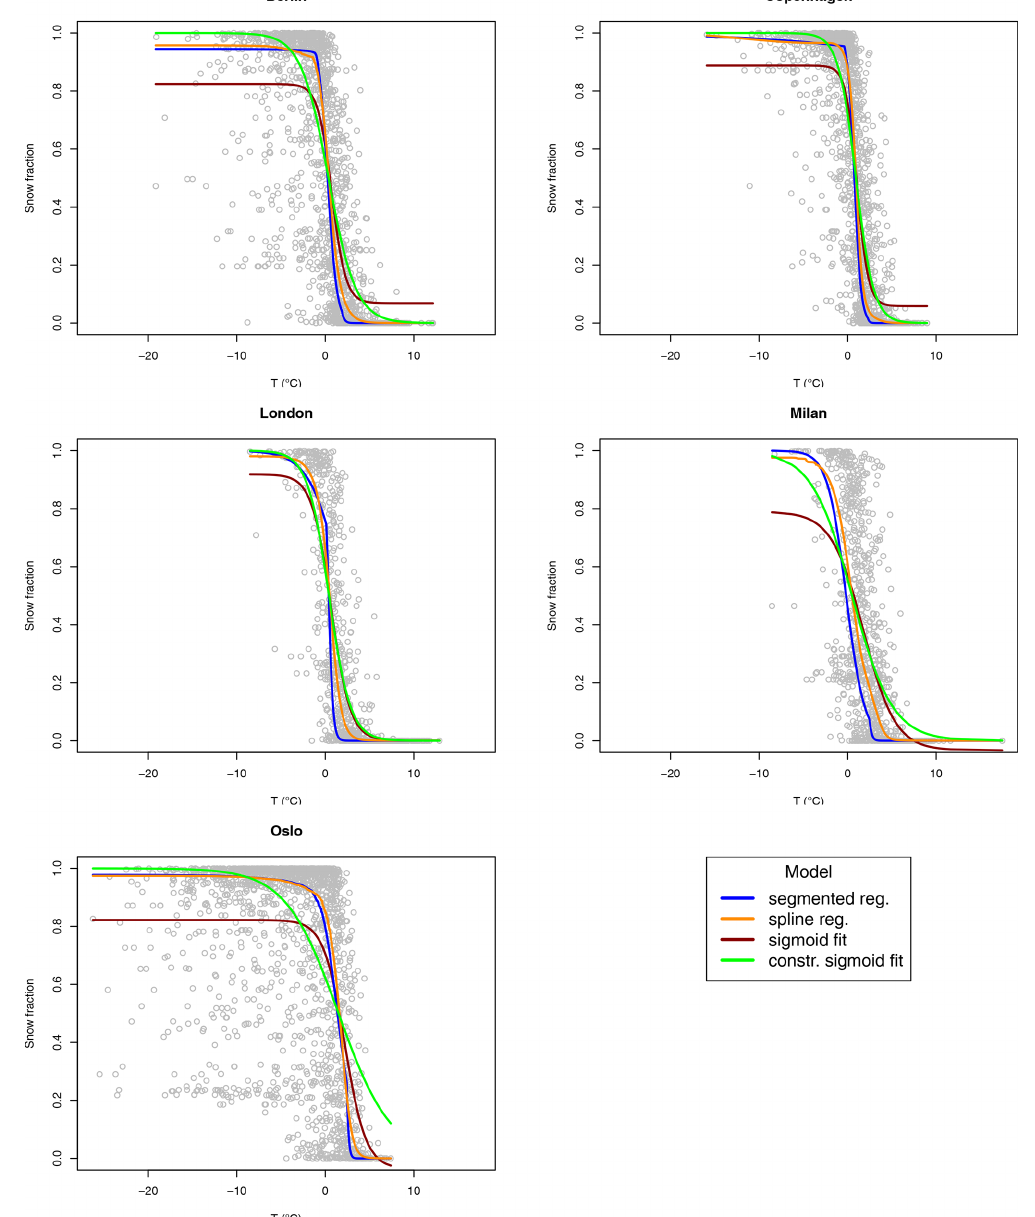
Figure 5. Snow fraction as a function of temperature for the five ERA5 grid points closest to some European cities (gray circles). Solid lines represent fitted values for the segmented logit-linear regression (blue), spline regression (orange), sigmoid fit (dark red), and constrained sigmoid fit